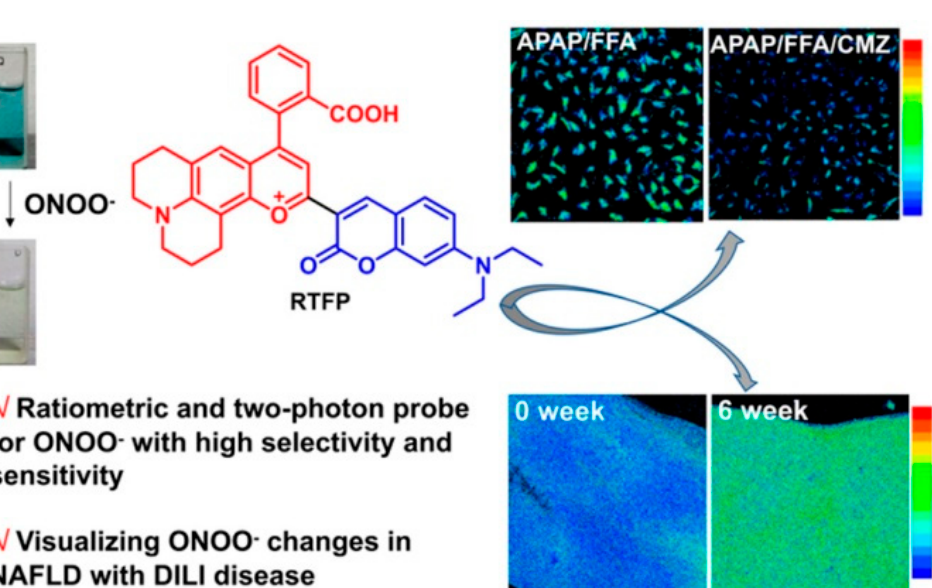
Figure 14. Schematic illustrations of RTFP for ONOO − tracking [44]. Copyright © 2023 American Chemical Society.